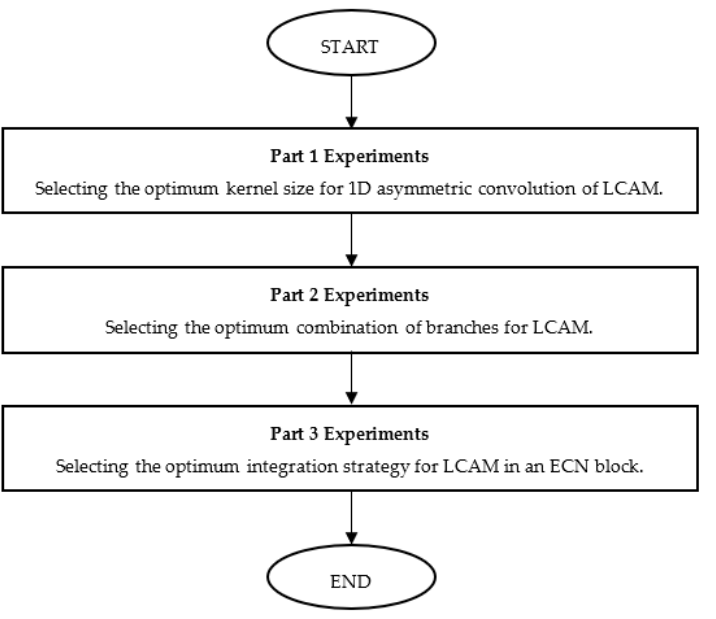
Figure 4. Flow chart illustrating experiments conducted based on hill climbing technique to tune and determine the optimum structure for LCAM.